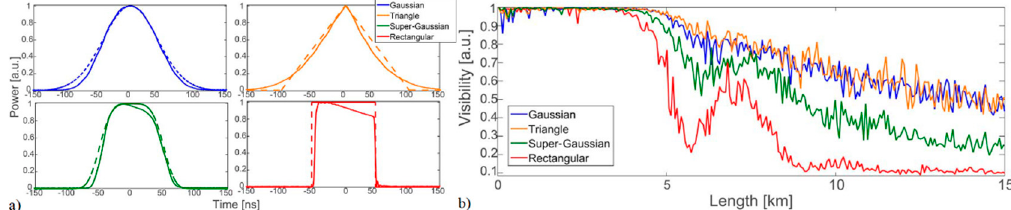
Figure 5. (From [26]) ( a ) Optical pulses with different intensity profiles (similar FWHM) used to probe a Φ OTDR system and ( b ) Correspondent Φ OTDR trace visibility for each pulse (all with the same pulse energy of 165 nJ), showing a clear performance improvement from square to other intensity profiles. @2016 The Optical Society [26].